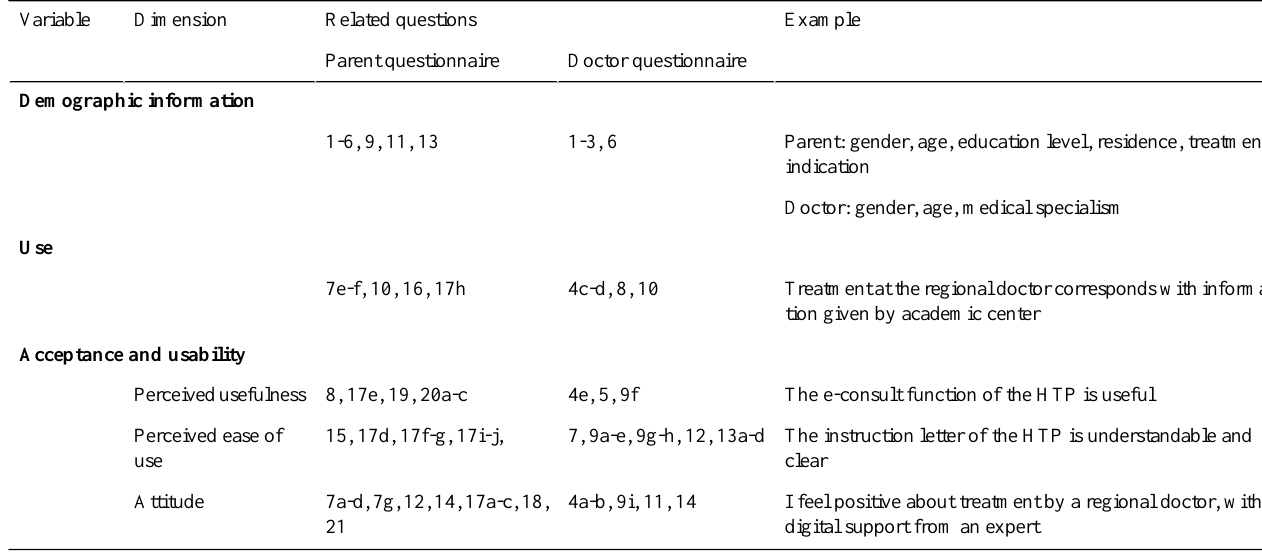
Table 1. Questions used to evaluate feasibility of the eHealth